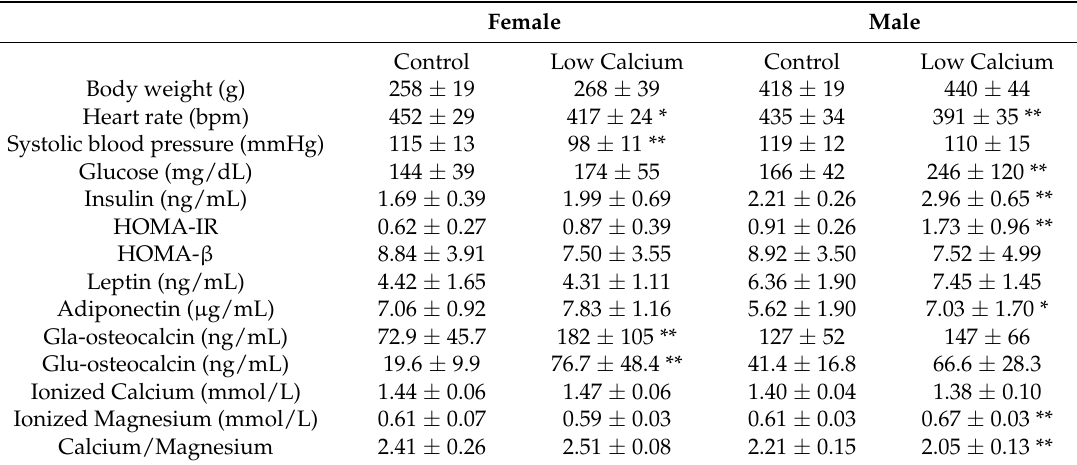
Table 2. Profile of each